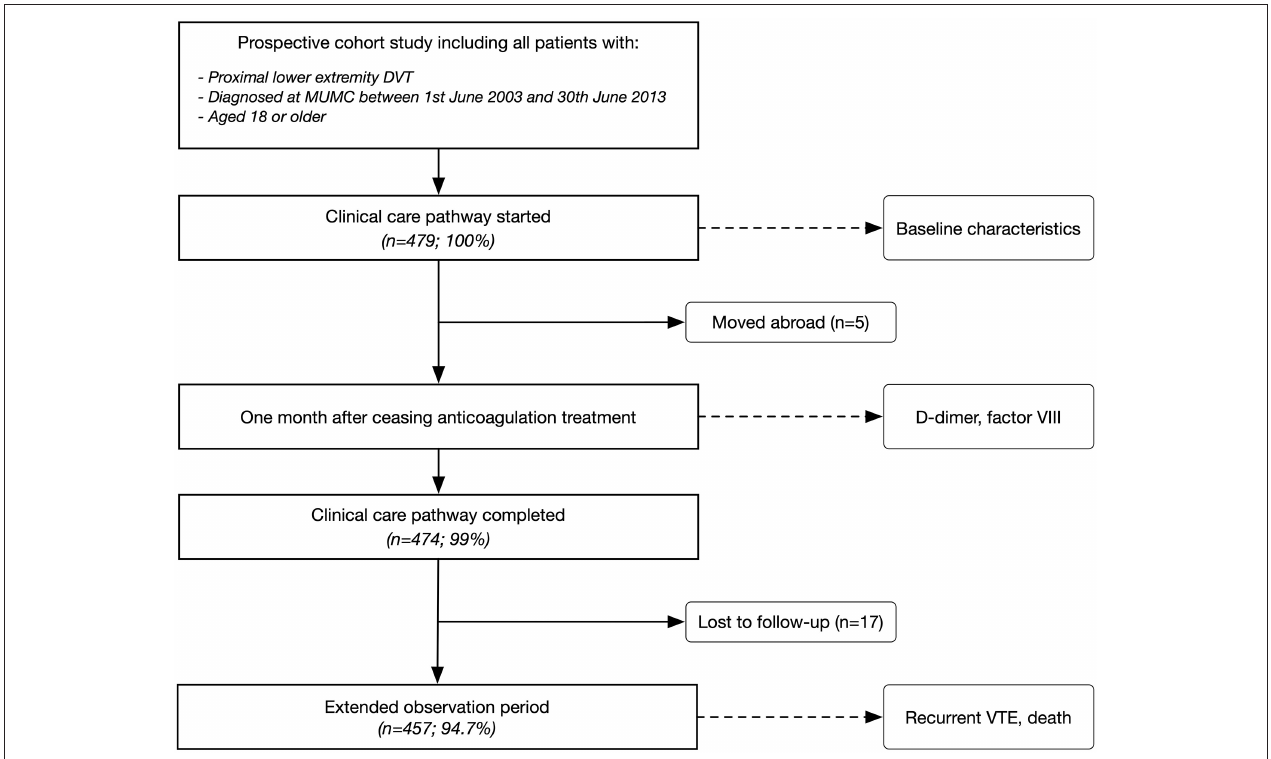
FIGURE 1 | Flow of the patients. MUMC, Maastricht University Medical Center.